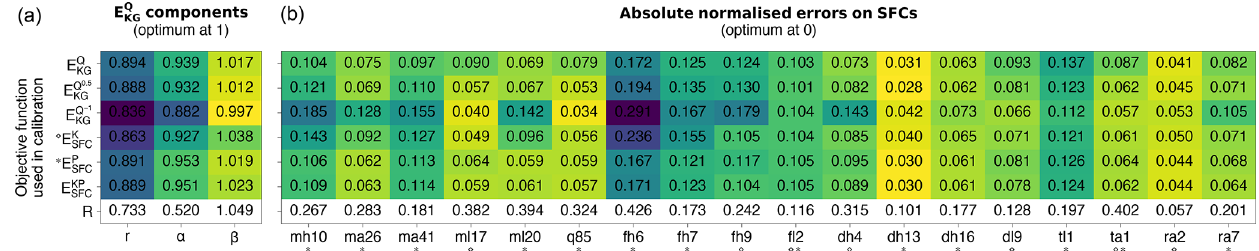
Figure 8. Comparison of performance in evaluation of the model calibrated with the six objective functions on individual components of the objective functions. Panel (a) compares them on the three components of the Kling–Gupta efficiency. Panel (b) compares them on the individual SFCs that are contained in the three tailored objective functions. A hollow diamond and an asterisk are used to display the SFCs belonging to E K and to E P , respectively. Note that all SFCs belong to E KP SFC SFC SFC